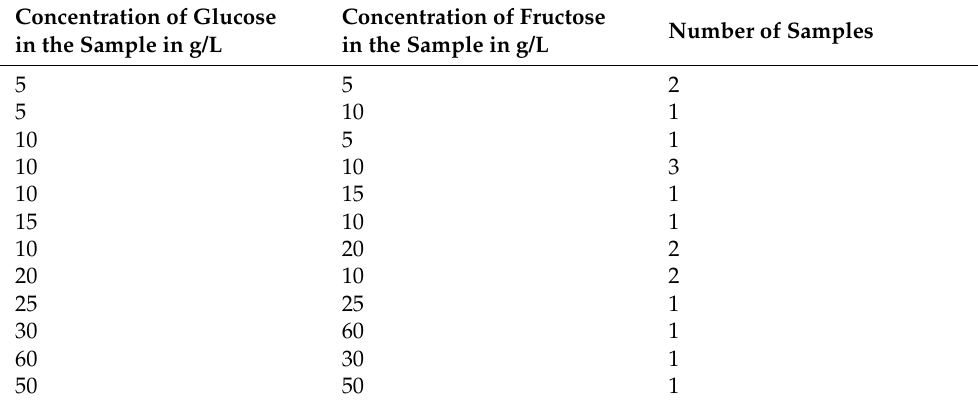
Table 2. Double monosaccharide samples: Number of analysed samples for each composition of concentrations of glucose and fructose in an aqueous solution.